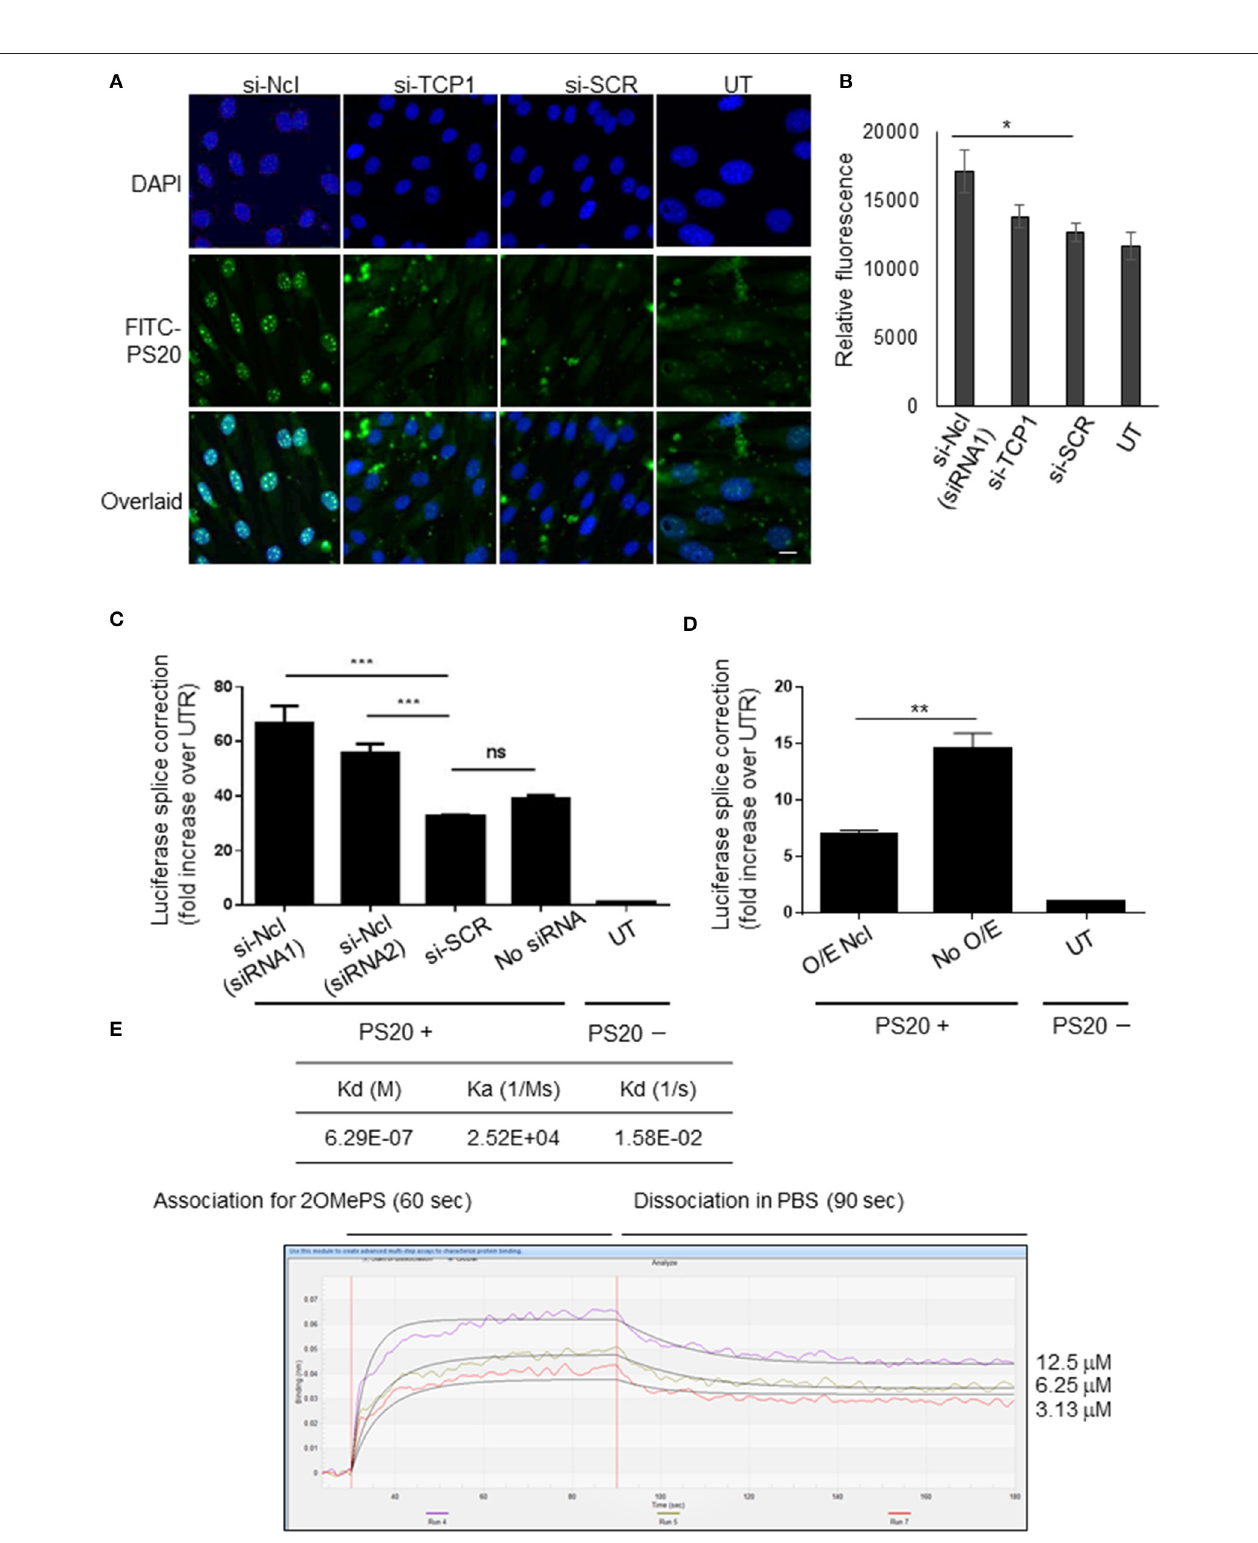
FIGURE 4 | Nucleolin negatively regulates the cellular uptake and splicing efficiency of PS-modified 2OMe SSOs. (A) Nucleolin knockdown by siRNA enhances the cellular uptake of FITC-conjugated 2OMe splice-switching oligonucleotides (SSOs) in C2C12 myoblasts. Cells are incubated with FITC-conjugated 2OMePS for